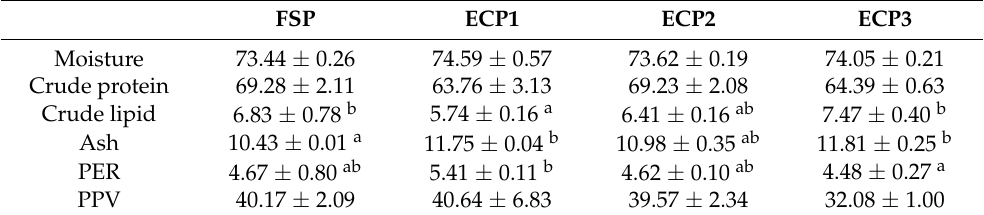
Table 5. Effect of fish soluble pulp and enzymatic chicken pulp on the whole-body composition of L. vannamei